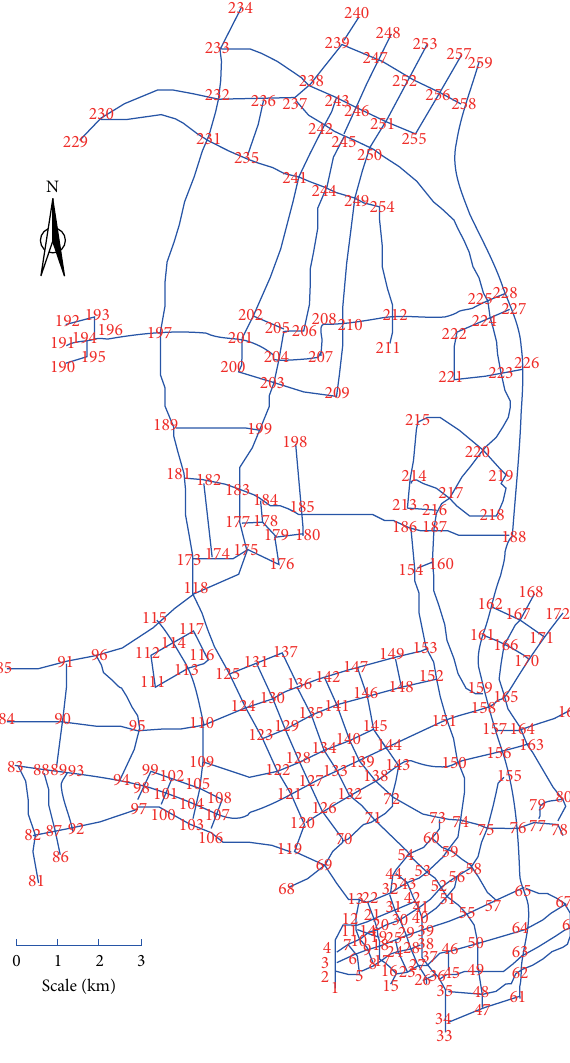
Figure 3: Layout of stops and links